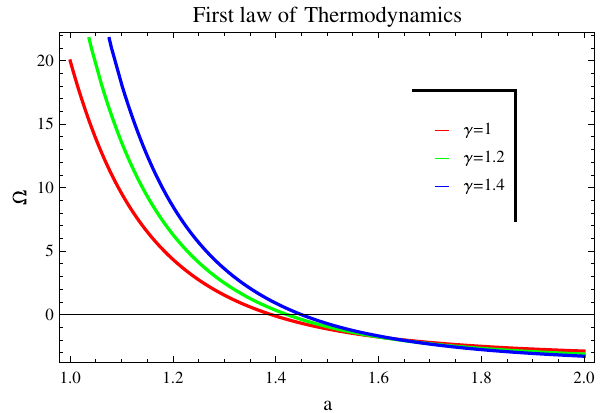
Fig. 3 Plot of (cid:10) versus a for logarithmic corrected entropy using k = 1 , λ = − 1 , α = − 1 , L p = 1 , β = 1 and b = 1